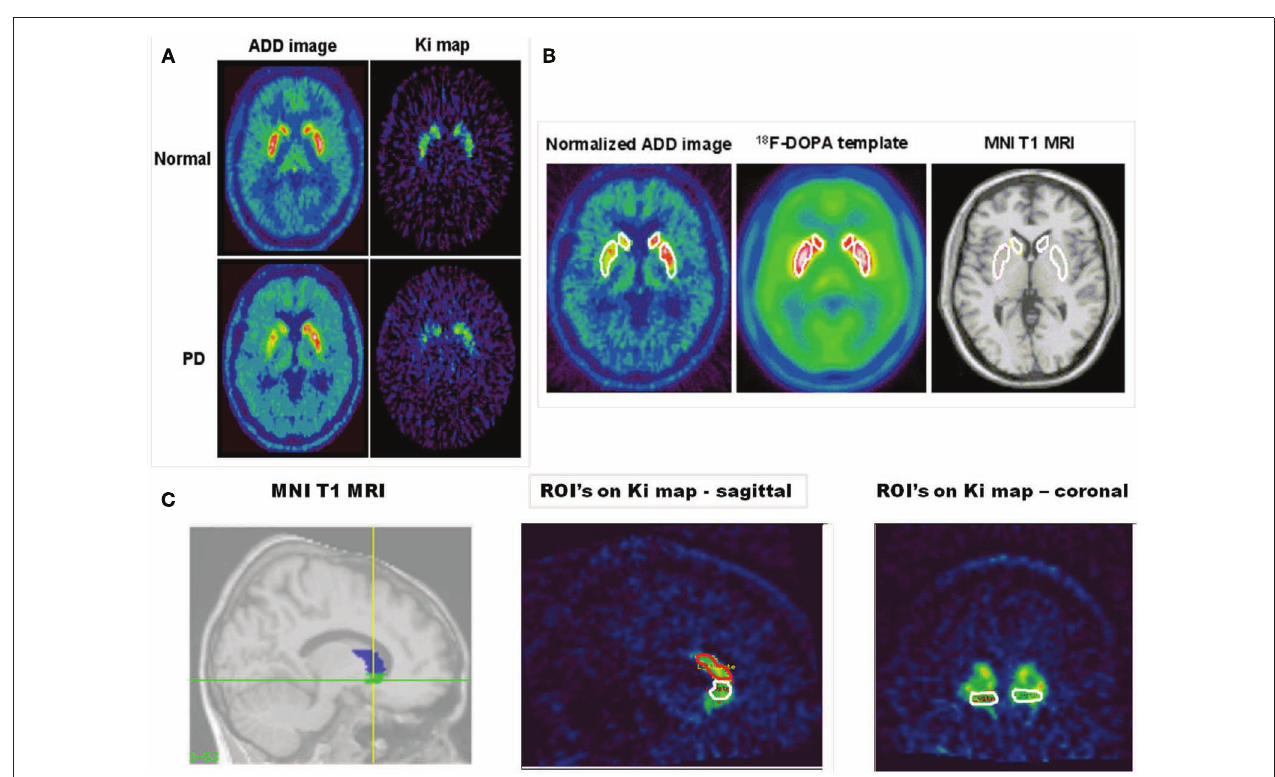
(created from five healthy controls) and the canonical single-subjectT1 MRI found in SPM 99. (C) Shows the template object map, with volumes shaded, for the ventral striatum and caudate nucleus overlain on the canonical single-subjectT1 MRI in sagittal section and next to it a spatially normalized K I image in sagittal section with the ventral striatum and caudate nucleus object map overlain. Also shown is a spatially normalized coronal section K I map through the ventral striatum with the object map overlain.